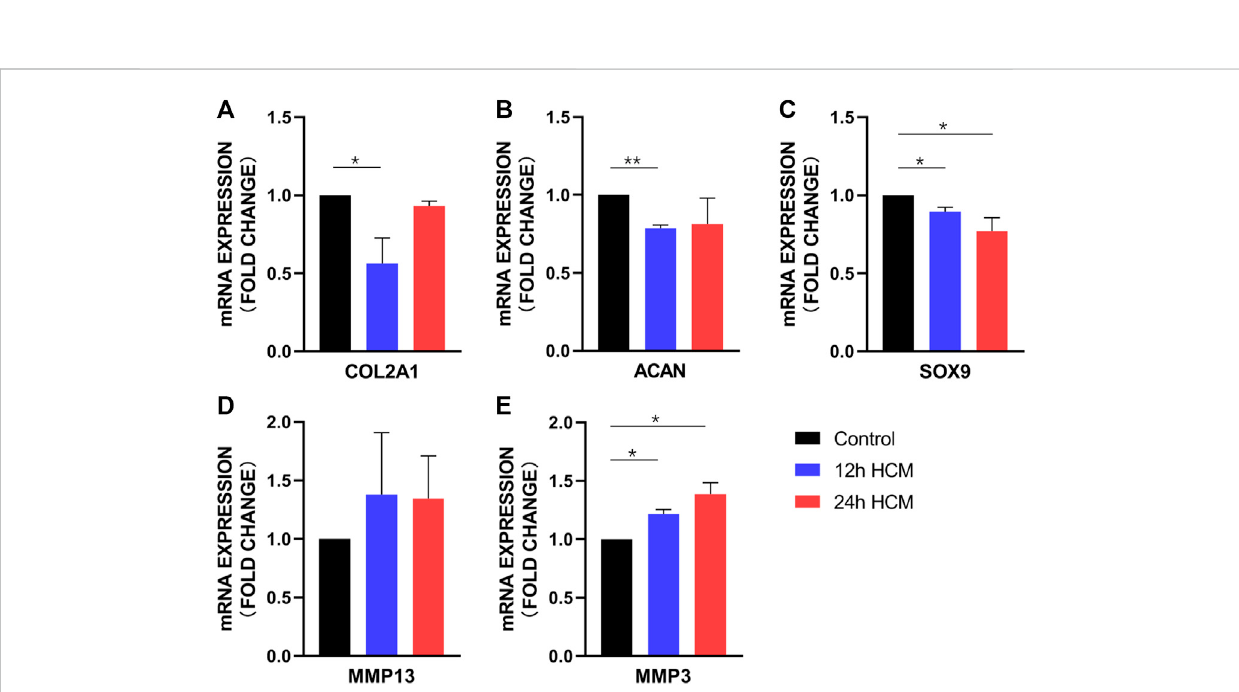
FIGURE 4 RT-PCR analysis of osteoarthritis biomarker mRNA levels in human primary chondrocytes stimulated with a conditioned medium from hypoxia for 24 h. (A) COL2A1, (B) ACAN,and (C) SOX9expressionwassigni fi cantlydecreasedinhumanprimarychondrocytesstimulatedwith12 hHCMcomparedto those stimulated with 12 h conditioned medium from normoxia. (A) COL2A1, (B) ACAN, and (C) SOX9 expression was decreased in human primary chondrocytes stimulated with 24 h HCM compared to those stimulated with 24 h NCM, with a signi fi cant difference in SOX9 expression but not in COL2A1 and ACAN expression. (D) MMP1 and (E) MMP3 expression was increased in human primary chondrocytes stimulated with 12 h and 24 h HCM compared to those stimulated with 12 and 24 h NCM, with a signi fi cant difference in MMP3 expression but not MMP13 expression.